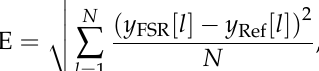
Table 6. Results of the extraction of speed-related gait parameters: the number of strides, the mean stride time, and the percentage of the stance phase. Values are given in mean